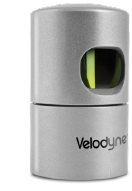
Figure 7: Canon PowerShot S110 camera